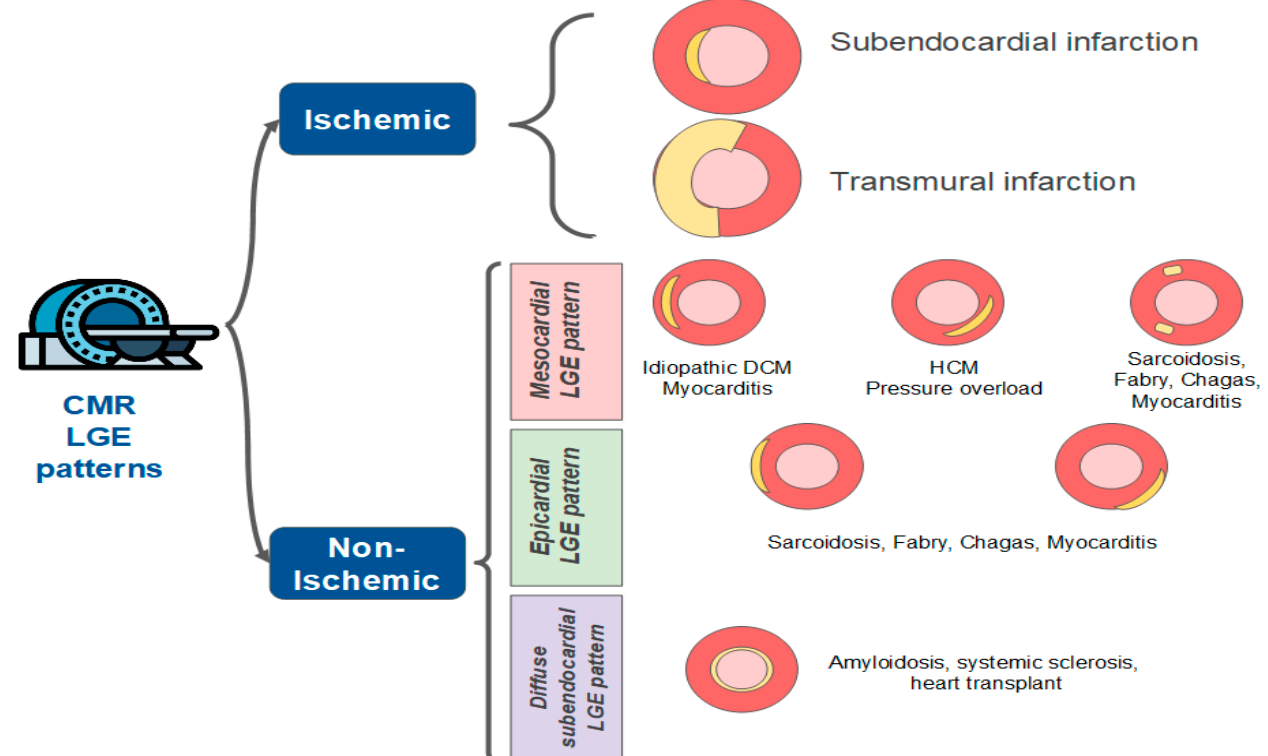
Figure 11. Late-gadolinium enhancement (LGE) patterns of myocardial injury. CMR: cardiac magnetic resonance; DCM: Dilated cardiomyopathy; HCM: Hypertrophic cardiomyopathy.